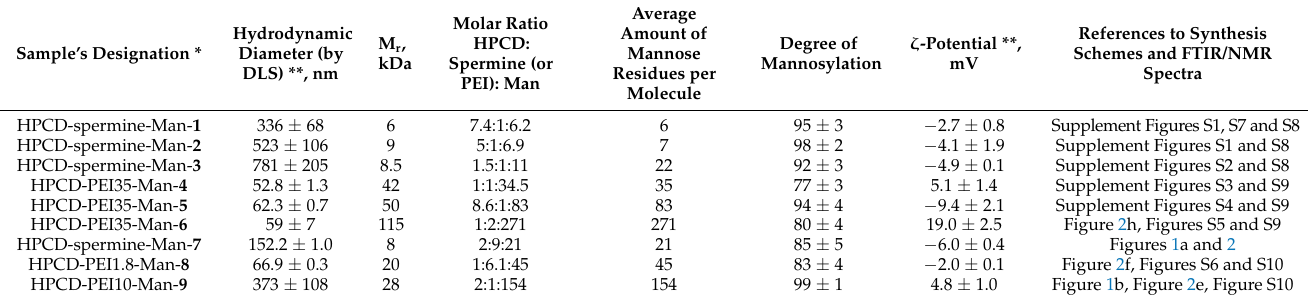
Table 1. Physical-chemical properties of obtained β -cyclodextrin conjugates.